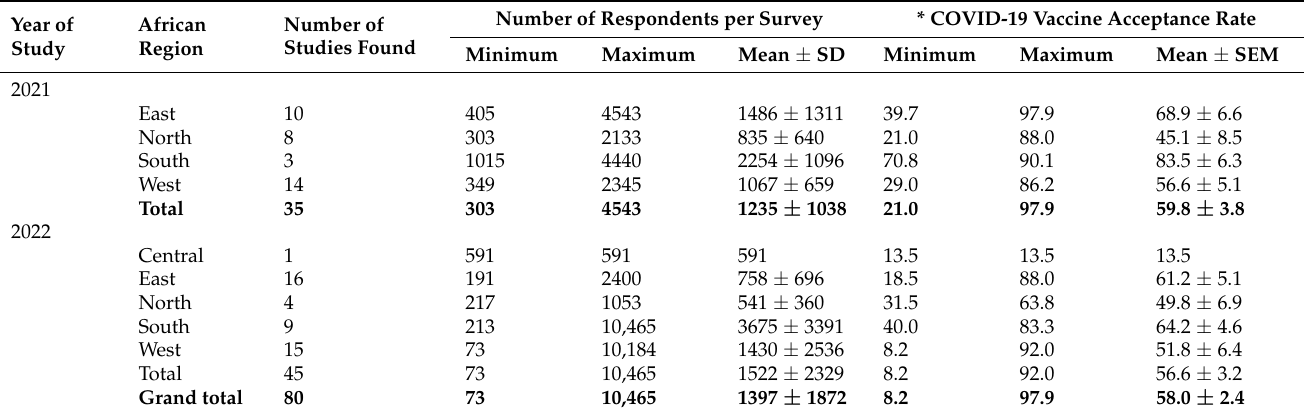
Table 2. Yearly and regional distributions of the overall reported COVID-19 vaccine acceptance rates in Africa between 2021 and